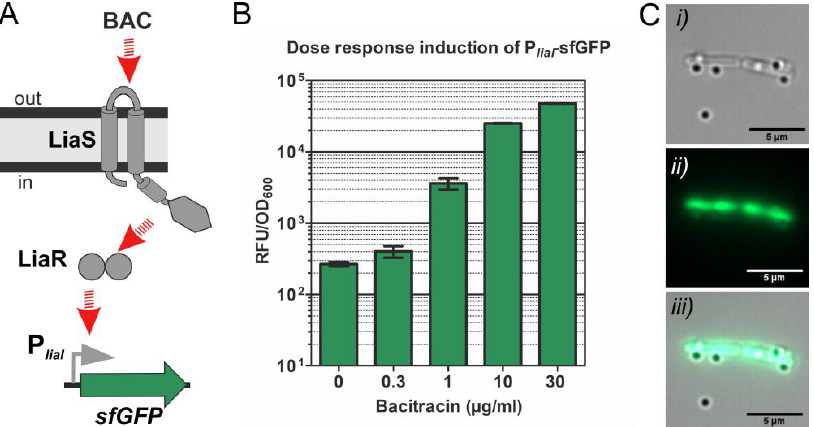
Figure 6. Whole-cell biosensor with dose-response readout. ( A ) Schematics for the whole-cell biosensor P liaI - sfGFP derived from the two-component system LiaRS. The gene coding for sfGFP is cloned downstream of the liaI promoter. BAC, stands for the inducer bacitracin. Red arrows indicate activation. See main text for details about the complete signal transduction process. ( B ) Dose-response induction of P liaI - sfGFP (strain TMB3909) by increasing concentrations of the antimicrobial peptide bacitracin. The output is expressed as relative fluorescence units (RFU) divided by the amount of cells